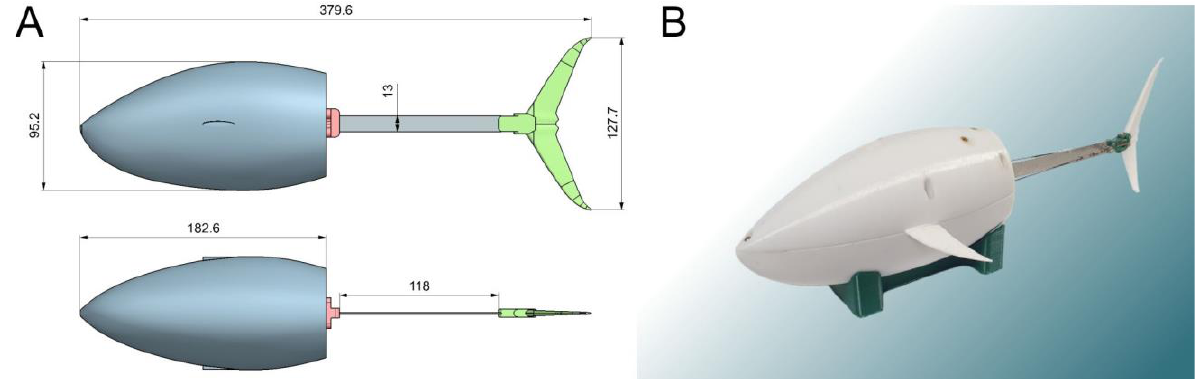
Figure 1. The robotic fish. ( A ) Dimensional drawing; ( B ) working prototype.